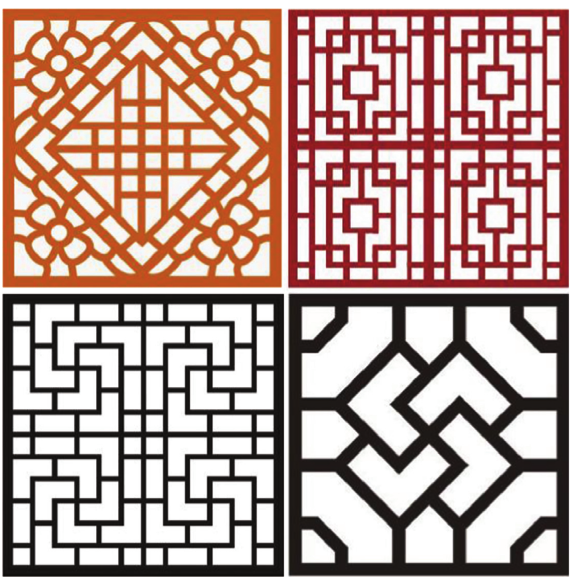
Figure 2: Classical window grille cross structure. Table 1: Antenna